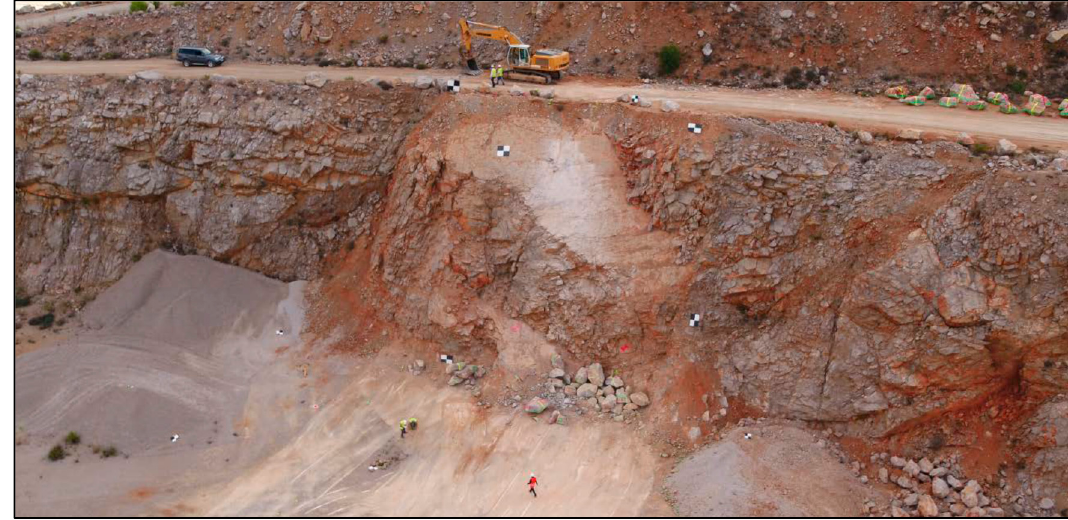
Figure 1. Picture of real-scale fragmentation test carried out at Foj limestone quarry (Test site 4).